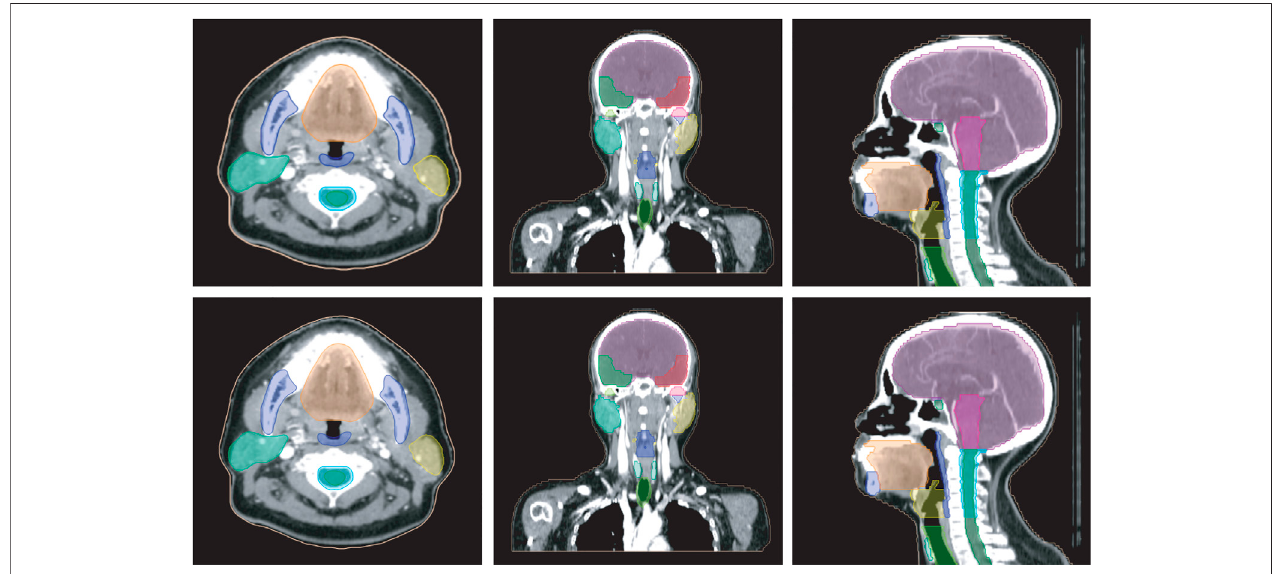
FIGURE 6 | Comparison of HaN OARs segmentation using EB-Net-based auto-contouring (upper) and the physician manual delineation (lower) .